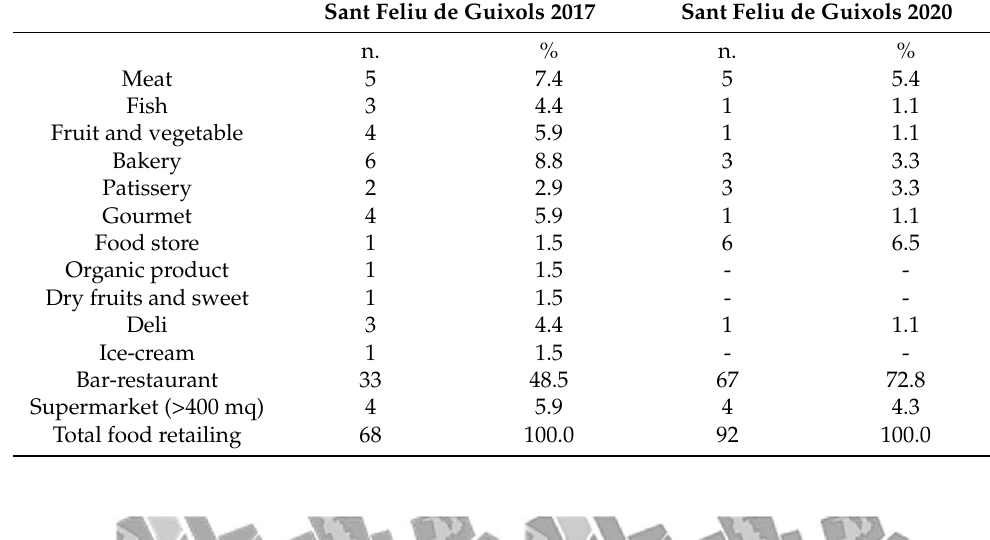
Table 2. Food stores in the centre of Sant Feliu de Gu í xols (2017 and 2020).